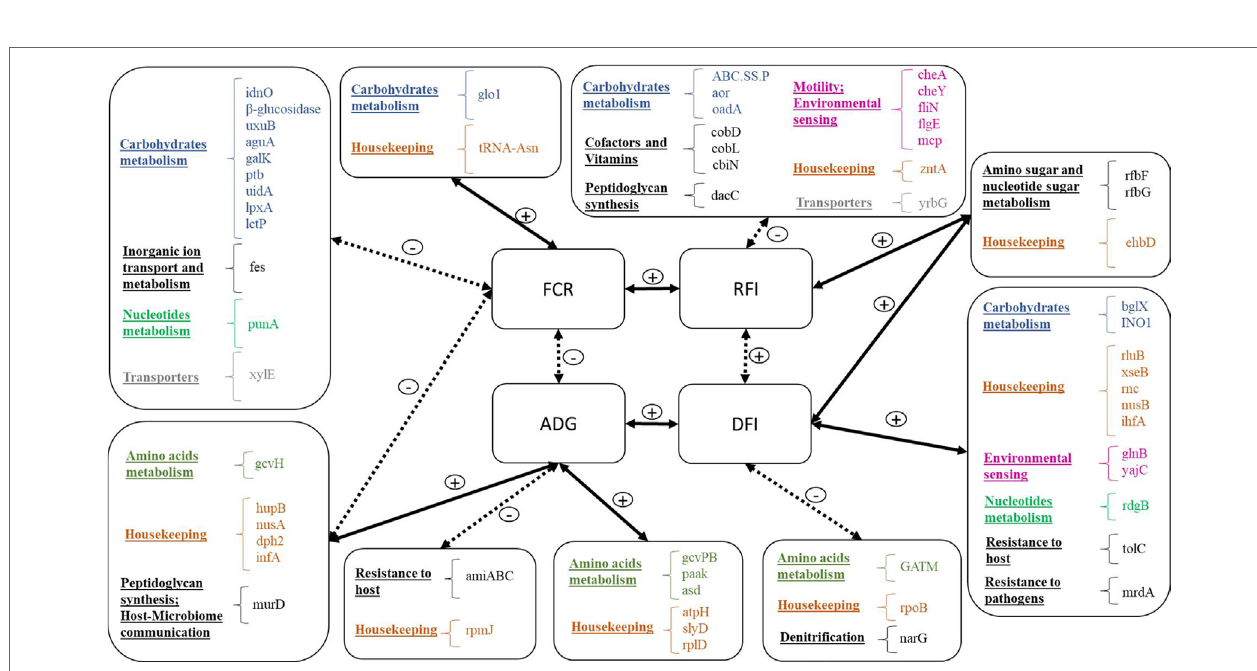
FIGURE 6 | Summary of microbial genes identified for the prediction of each trait: Traits are located in the four central boxes: FCR, feed conversion ratio; ADG, average daily gain; RFI, residual feed intake; DFI, daily feed intake. Solid lines represent positive correlations, and dotted lines represent negative correlations. Microbial genes are listed in the outside boxes, organized by general function, and each general function is represented by a different